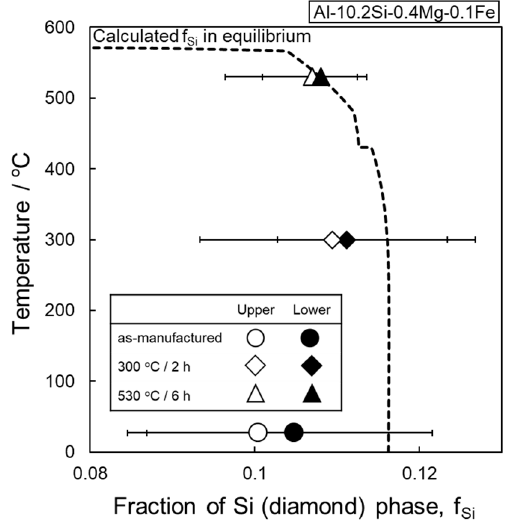
Figure 16. Experimentally measured area fraction of Si particles in node portion of the lattice specimen plotted with annealing temperature, comparing with the calculated volume fraction of Si particles in the studied alloy composition in equilibrium.